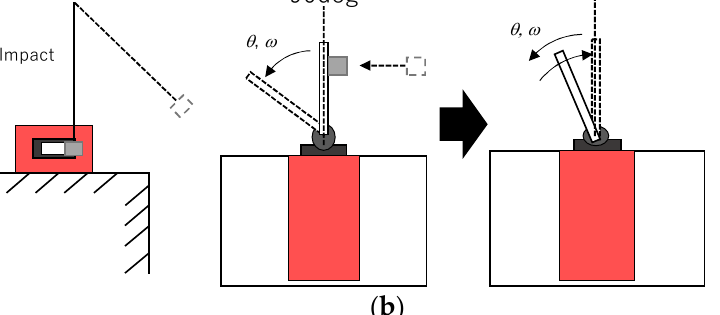
① Tie a weight to the end of the string and